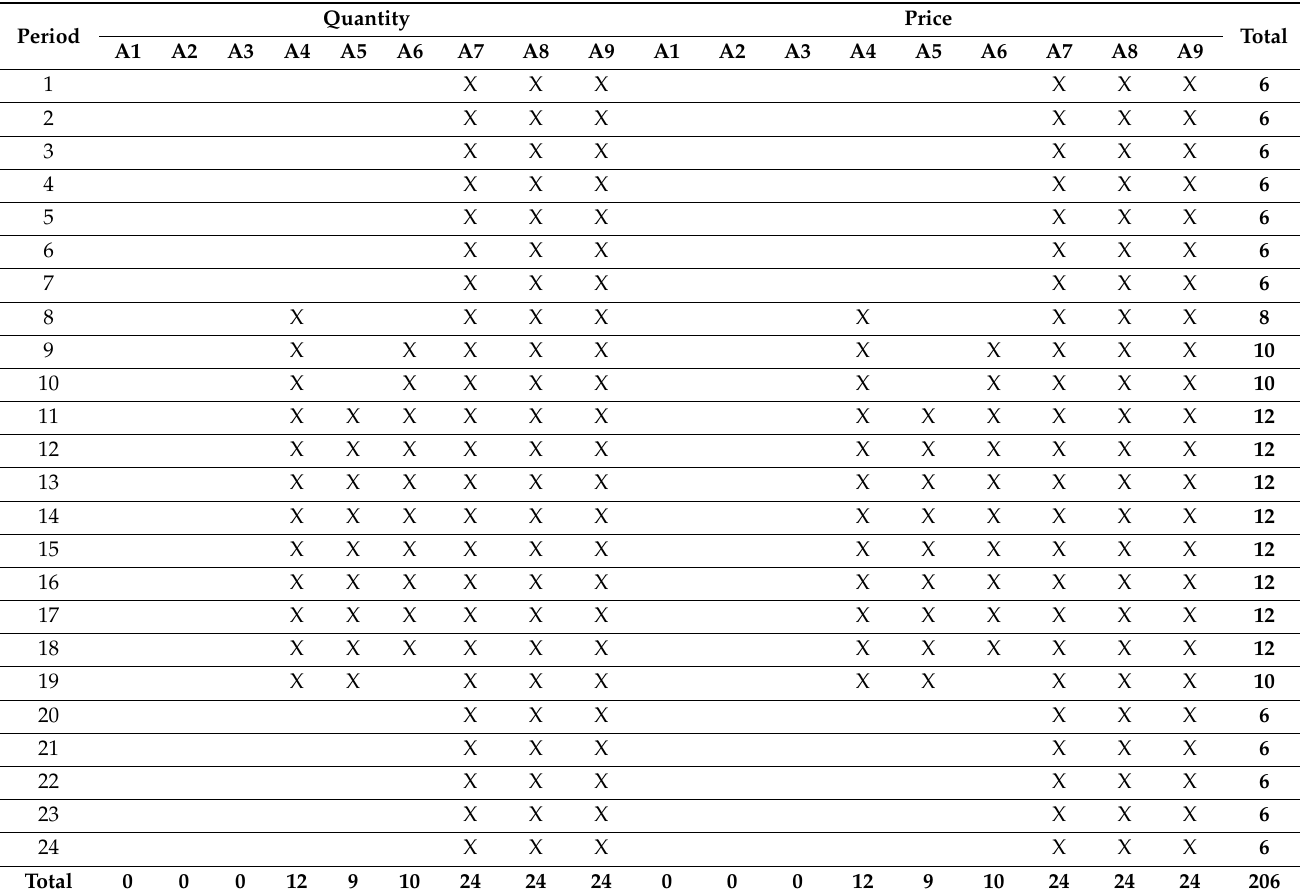
Table 1. Fixed and changeable decision variables for nine